Question: Sum up the contents of this chart in one sentence.
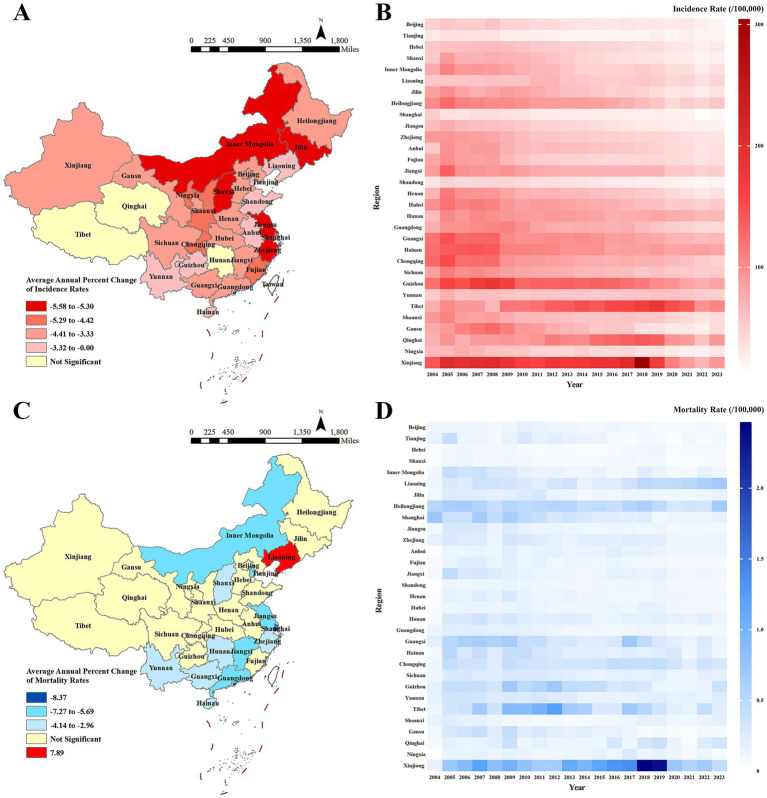
Answer: Spatial distribution of average annual percentage change (AAPC) and temporal heatmaps of PTB incidence and mortality in China, 2004–2023. (A) Map of AAPC in incidence. Except for three provinces (Tibet, Hunan, and Qinghai), the remaining 28 provinces showed a statistically significant decreasing trend ( p < 0.05). The fastest declines were observed in three northern provinces (Inner Mongolia, Jilin, and Shanxi) and two eastern coastal provinces (Jiangsu and Zhejiang). (B) Heatmap of annual incidence time series (31 provinces). Each row represents a province; color intensity reflects the incidence rate over time. (C) Map of AAPC in mortality. Only 12 provinces exhibited a significant decreasing trend: Yunnan, Guangxi, Guangdong, Hunan, Jiangxi, Hainan, Jiangsu, Shanghai, Zhejiang, Tianjin, Shanxi, and Inner Mongolia. The fastest decline occurred in Shanghai. Notably, only Liaoning Province showed a significant increasing trend. (D) Heatmap of annual mortality time series (31 provinces). Each row represents a province; color intensity reflects the mortality rate over time. AAPC and its significance were estimated using joinpoint regression analysis ( p < 0.05).